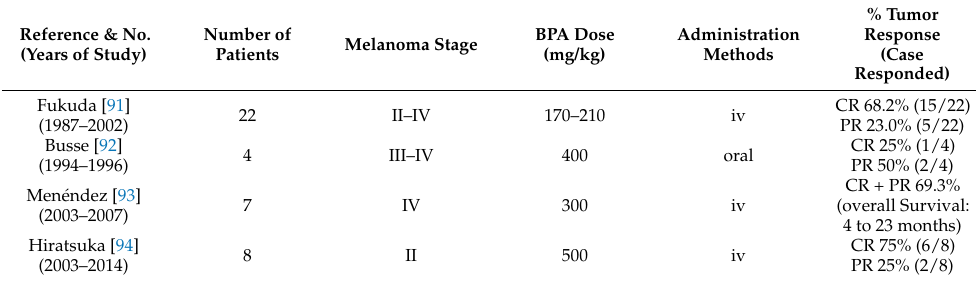
Table 4. Clinical results of BNCTT for cutaneous melanoma using